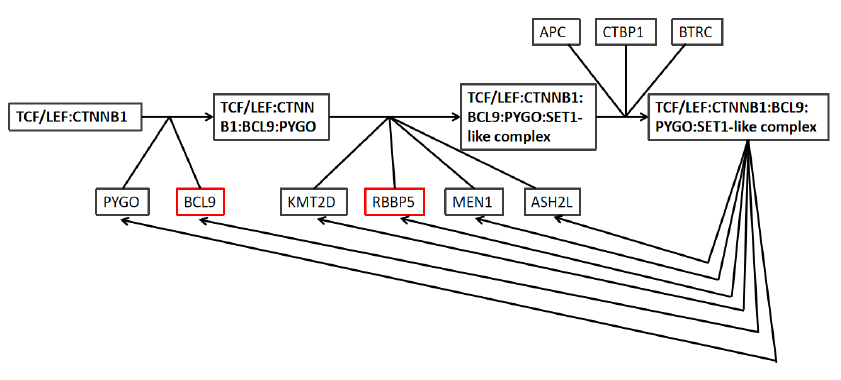
Figure 8. Gene pathways in response to TCF-related instructions of the Wnt pathway. The red boxes indicate the locations of RBBP5 and BCL9 .